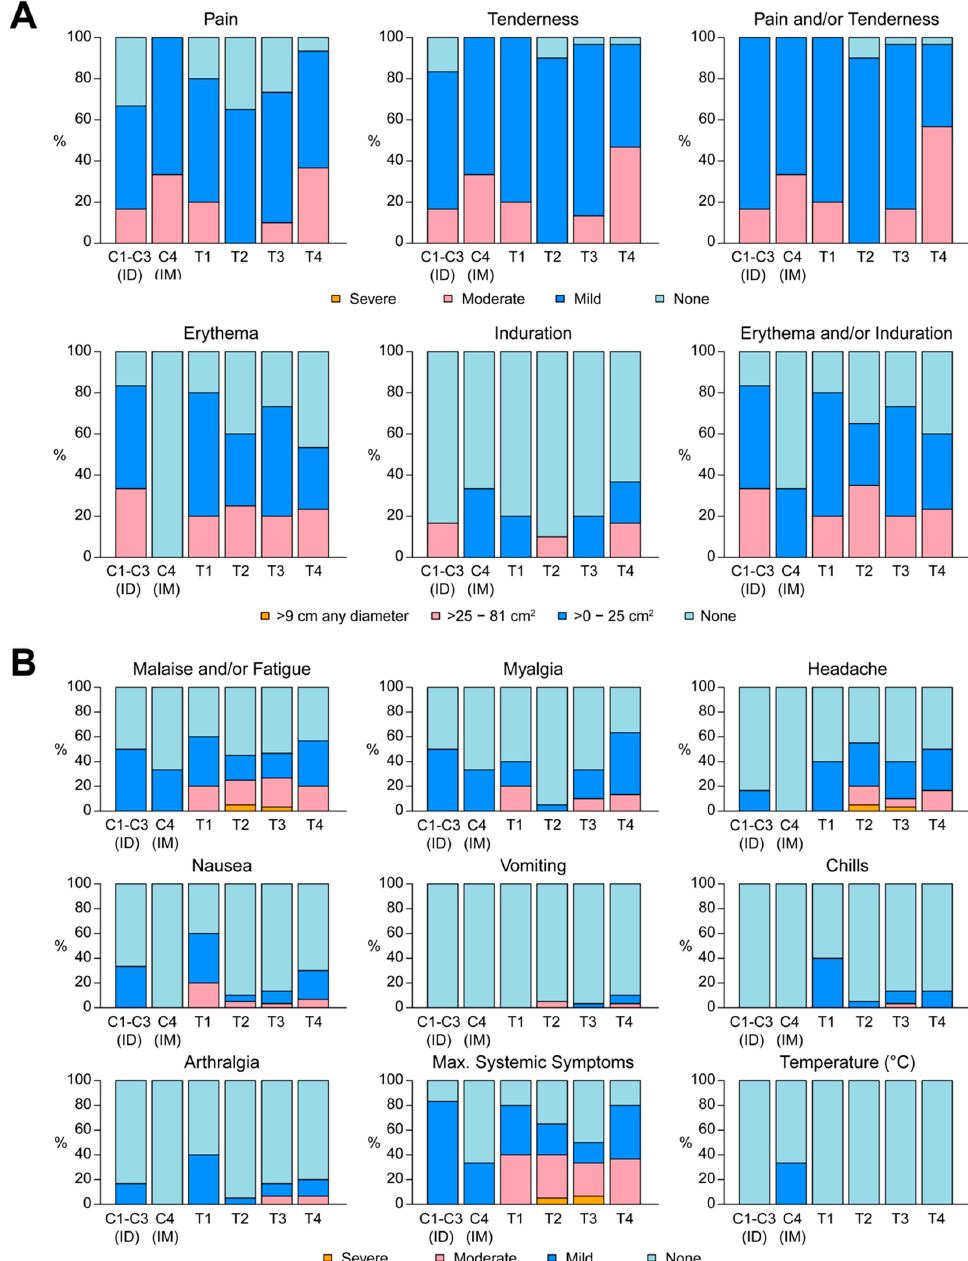
Figure 3. Local and systemic reactogenicity. ( A ) Maximum solicited local reactogenicity (pain, tenderness, erythema, induration) by treatment group. Bar graphs show the percentage of participants in each group reporting the specified maximum severity during the reactogenicity period (7 days). ( B ) Maximum solicited systemic reactogenicity (malaise/fatigue, myalgia, headache, nausea, vomiting, chills, arthralgia) by treatment group. ID = Intradermal; IM = intramuscular. C1–C4 served as the control groups for each of the four treatment groups T1–T4.